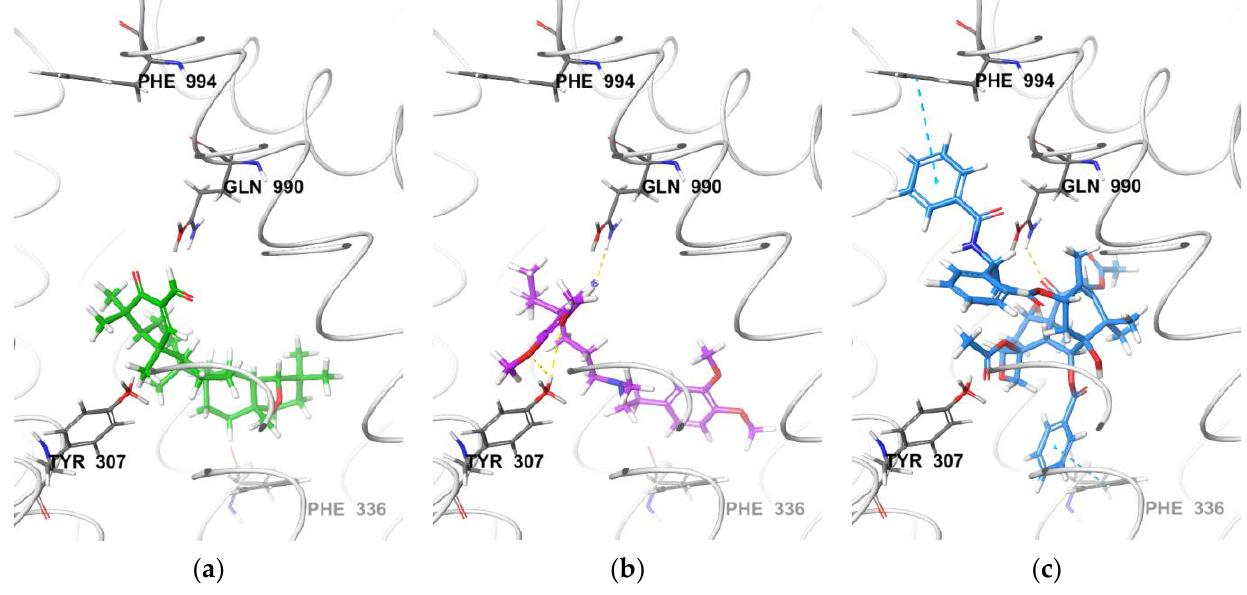
Figure 2. Comparison of the best GOLD docking conformations with human P-gp (PDB ID: 6QEX) for ( a ) OA ; ( b ) verapamil; and ( c ) co-crystallized taxol.